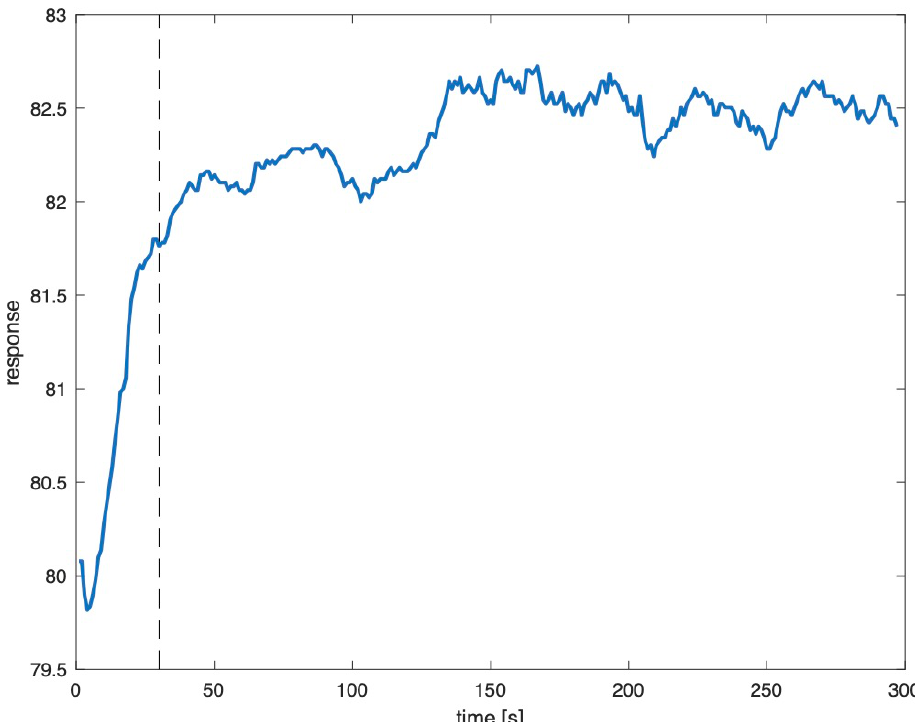
Figure 2. Example of transition phase (left of dashed line) and stable phase (right of dashed line) on IMS channel 1 for cinnamon measured from jar [6].